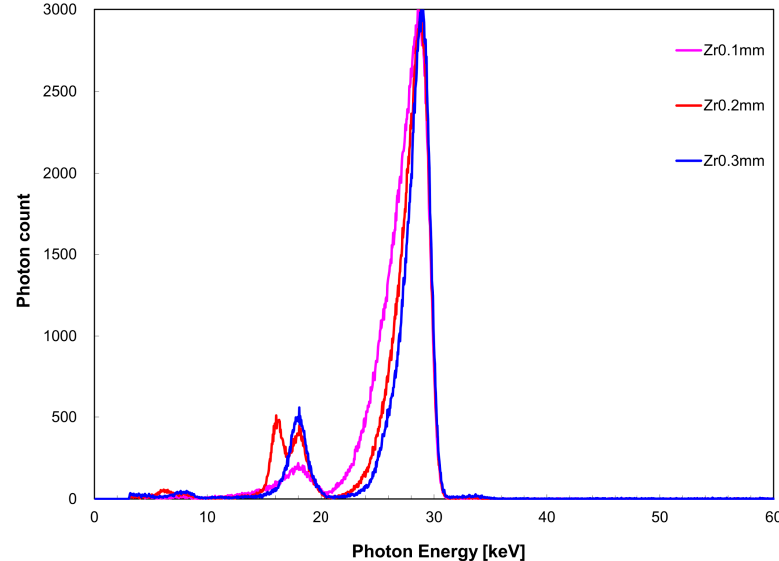
Figure 7. Zirconium filter thickness dependence of X-ray spectrum when the tin filter thickness was 0.3 mm.